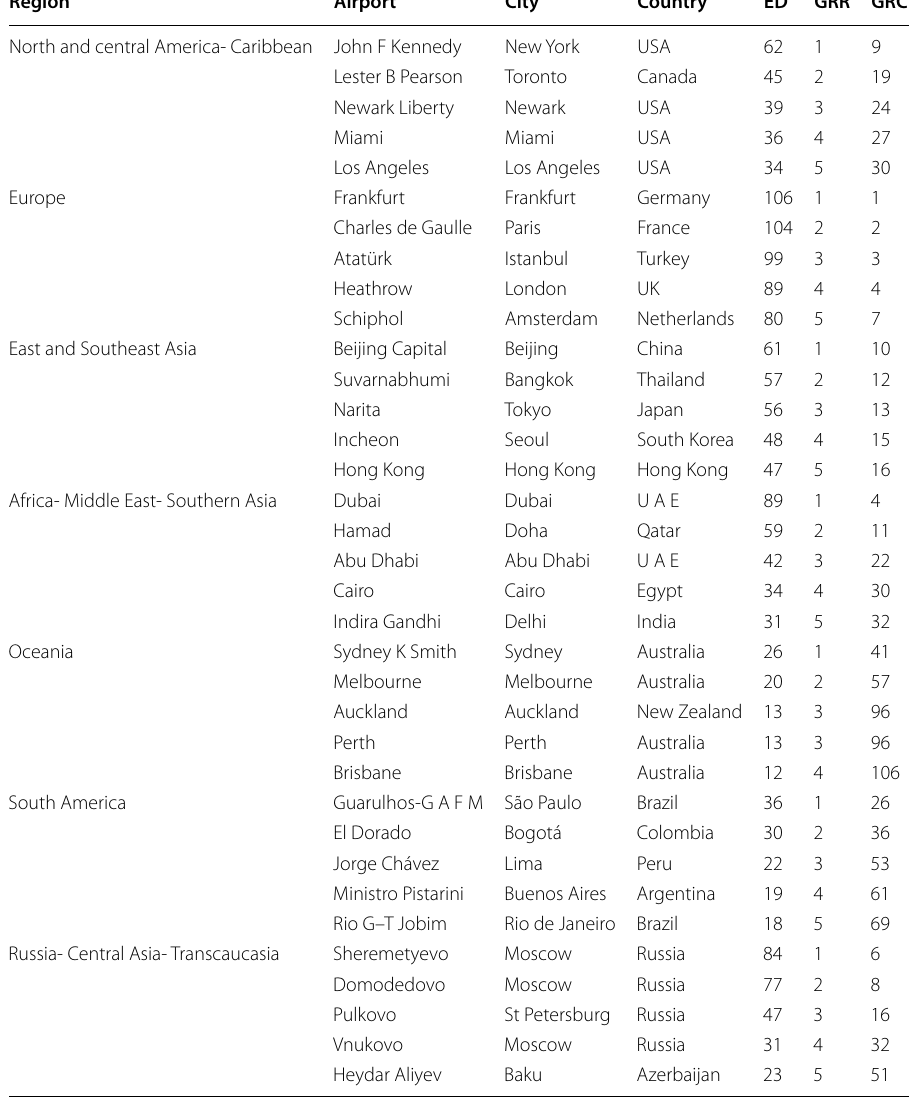
The top five inter-regional hubs in each region are reported. ED is the external degree. It measures the number of connections of an airport with airports located in the large global component. GRR is the global rank of the airport in its region. GRC is the global rank in the global component is the airport rank in the global component by decreasing external degree